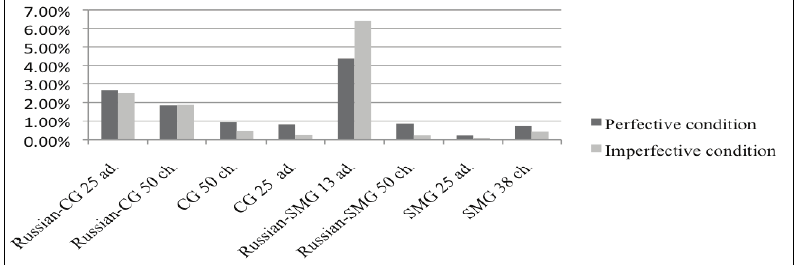
Figure 13: Perfective vs. imperfective condition in the written task